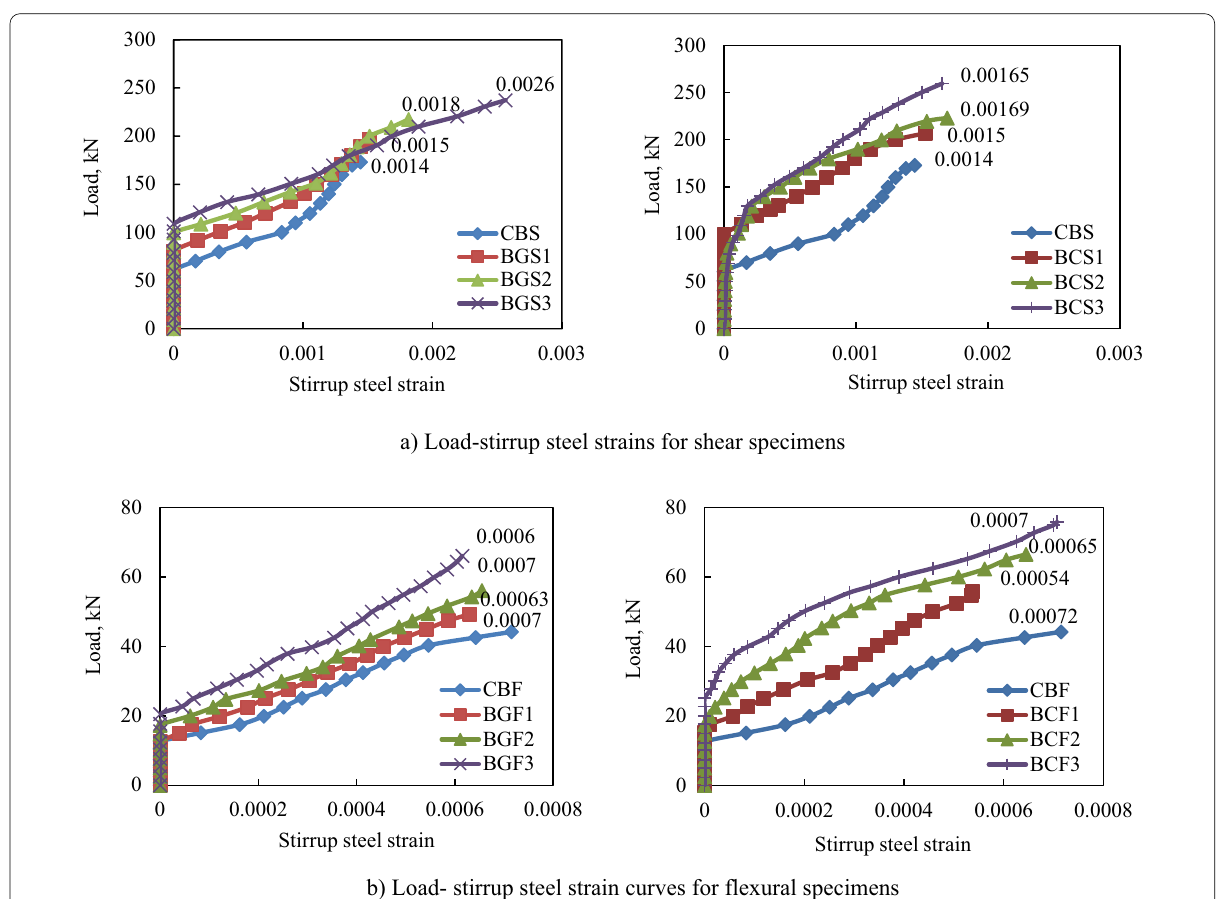
Fig. 13 Load–Stirrups steel strain curves for all